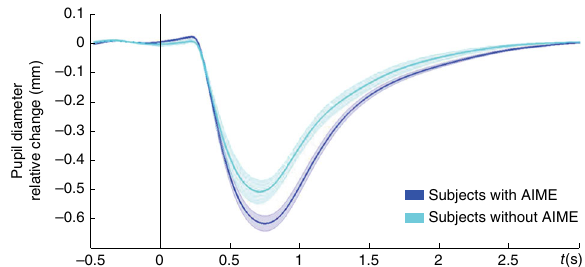
Fig. 4 AIME and pupillary light-re fl ex. Reduced pupillary light-re fl ex constriction for participants that do not show AIME. Average pupil diameter change relative to baseline is plotted for two groups: the 22 participants completing Exp 6 who show enhanced memory for Go vs. NoGo stimuli (blue), and the remaining six participants who do not (light blue). Shaded error bars pertain to